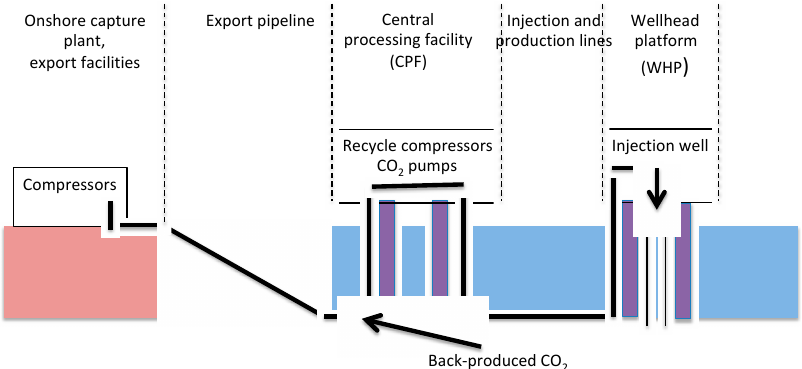
Figure 1. Schematic diagram of offshore CO 2 -EOR project facilities. Based on an illustration in Reference [15].